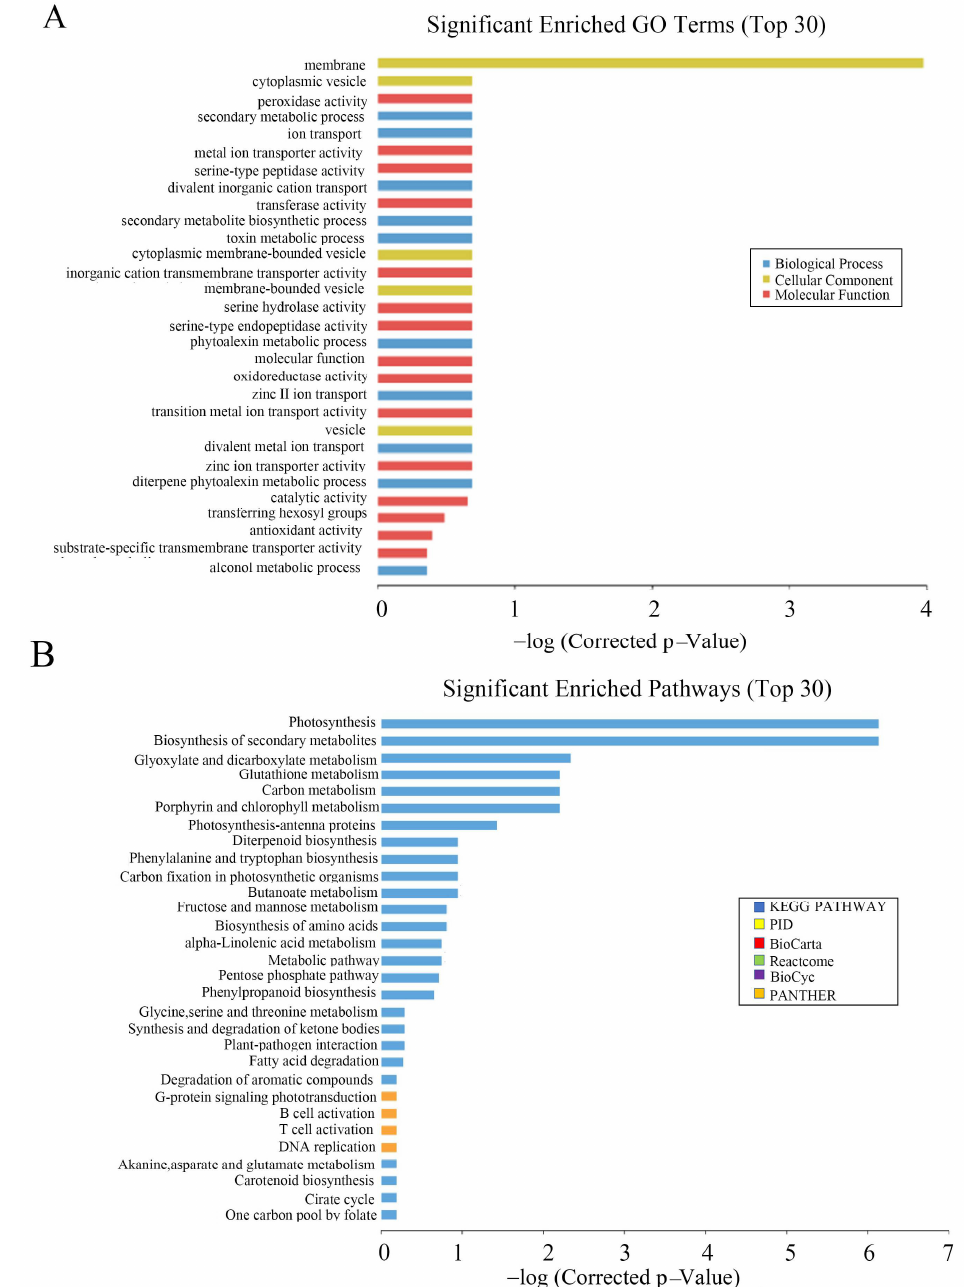
Figure 8. Microarray analysis of OsCAT3 crispr transgenic plants. ( A ): Significant enriched GO Terms of differentially expressed genes. ( B ): Significant enriched pathways of differentially expressed genes.